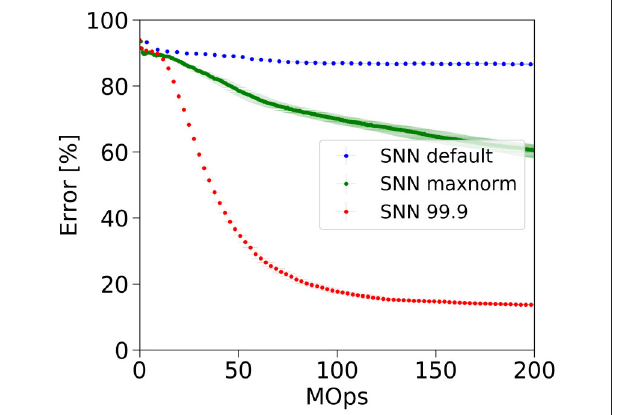
FIGURE 3 | Accuracy-latency trade-off. Robust parameter normalization (red) enables our spiking network to correctly classify CIFAR-10 samples much faster than using our previous max-normalization (green). Not normalizing leads to classification at chance level